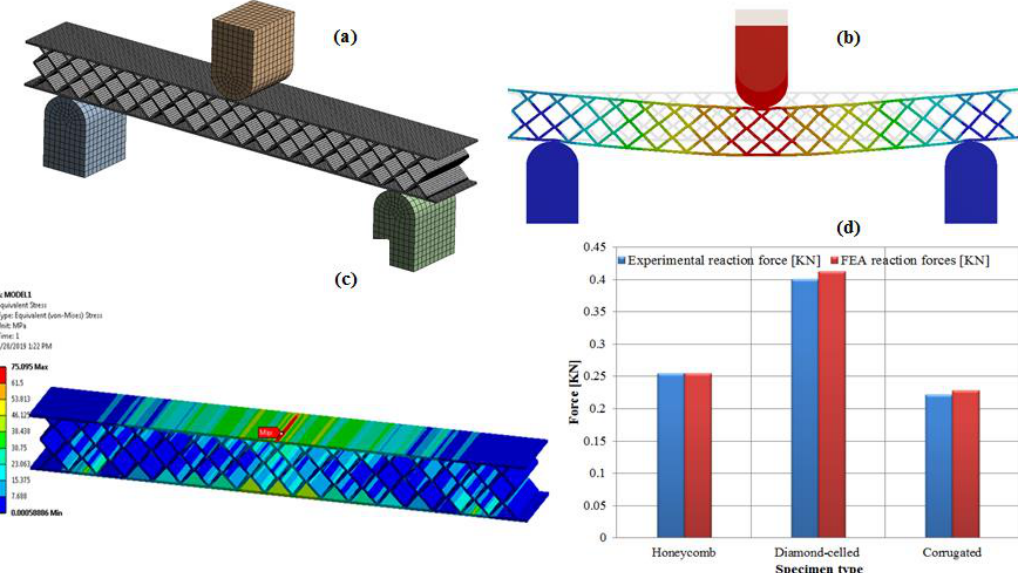
Figure 19. Finite element analysis subject to three-point bending loading: ( a ) finite element analysis (FEA) model—three-point bending; ( b ) deflection of specimen; ( c ) equivalent stress distribution; ( d ) comparative study of reaction forces.